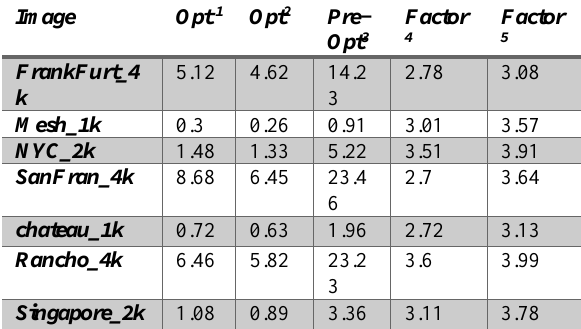
Table. 4 Compares the encoding optimization gained for various I3S datasets by using Compression Level 1 and the new geospatial focused compression level 0 settings (using single multithreading). Less values in the Opt columns means the task completed